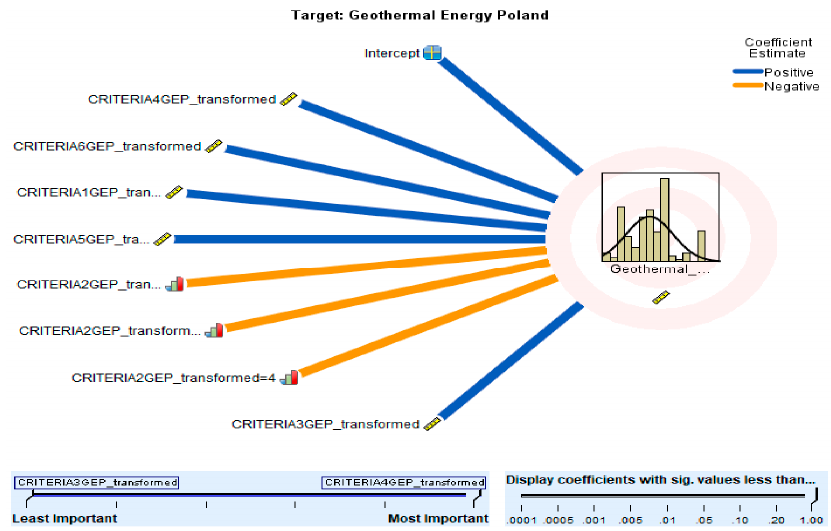
Figure 11. HE India GCV Criteria Source: ALM Analysis SPSS by Author.